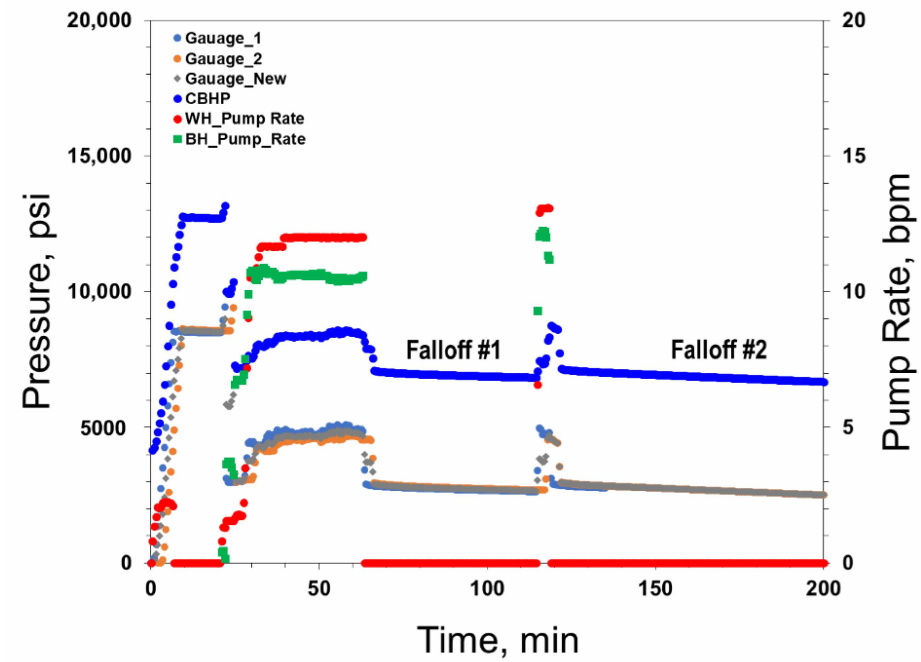
Figure 4. DFIT operations for Well #2, presenting injection and pressure profiles